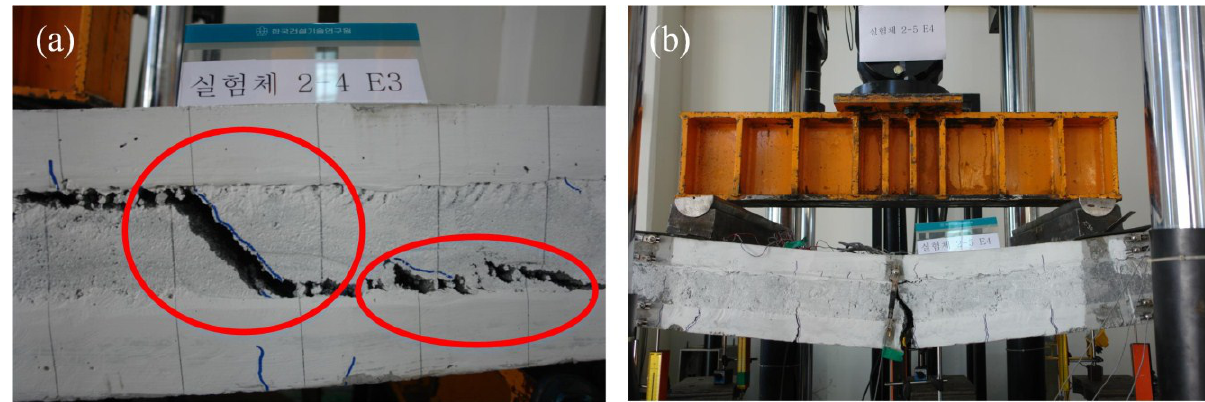
Figure 7. Load-deflection curve of the specimen using expanded polystyrene (EPS) insulation.